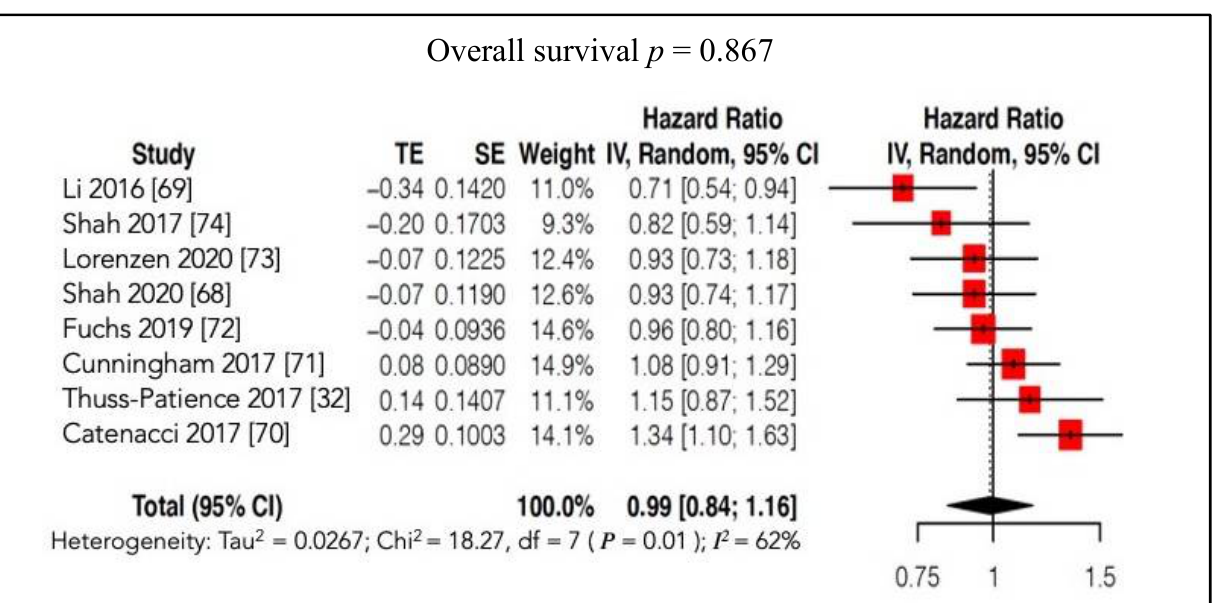
Figure 4. Forest plot of comparison: molecular-targeted therapy alone/plus chemotherapy versus chemotherapy alone/placebo. Main analyses; outcome: overall survival.